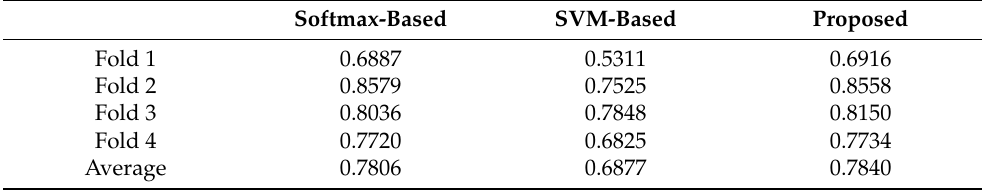
Table 1. Cross-validation accuracy of the three transfer learning models on breast cancer